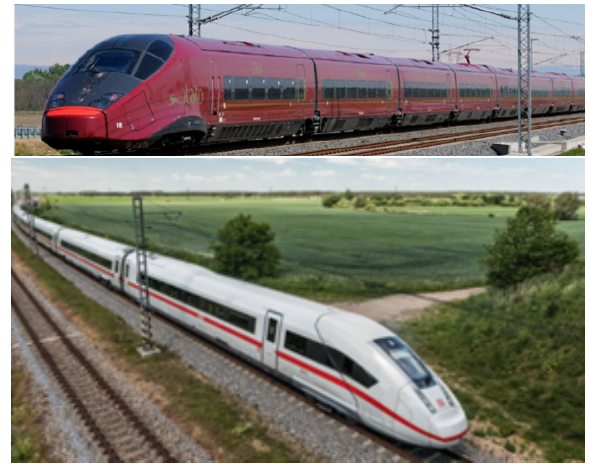
Figure 2. High speed AGV or ICE 4 for passenger transport in Czech Republic?